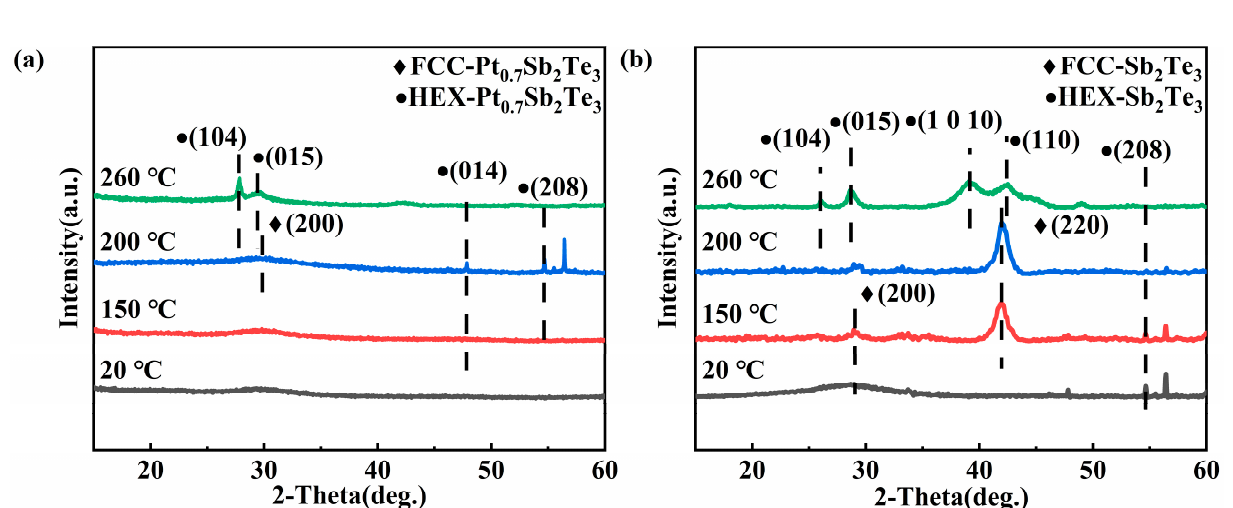
Figure 2. XRD results of the Sb 2 Te 3 and PST. ( a , b ) XRD curves of PST and Sb 2 Te 3 films were annealed at 150 °C, 200 °C, and 260 °C for 5 min in an N 2 atmosphere. at 150 ◦ C, 200 ◦ C, and 260 ◦ C for 5 min in an N 2